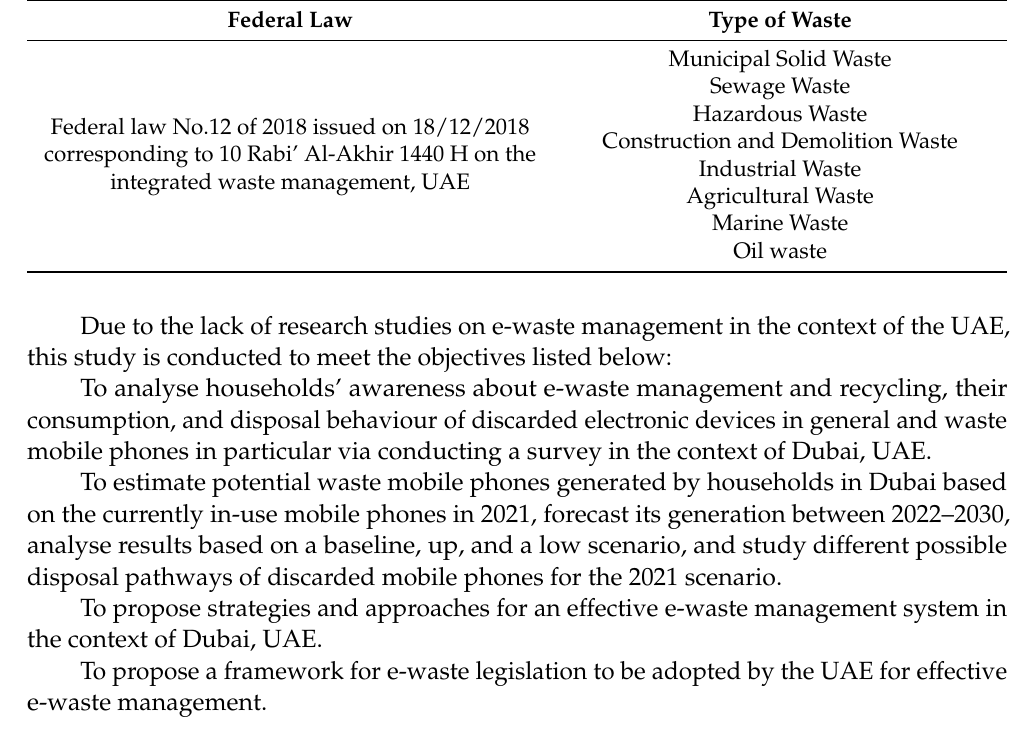
Table 2. Types of waste included in the federal law No.12 of 2018 on integrated waste management, UAE [21]. Federal Law Type of Waste